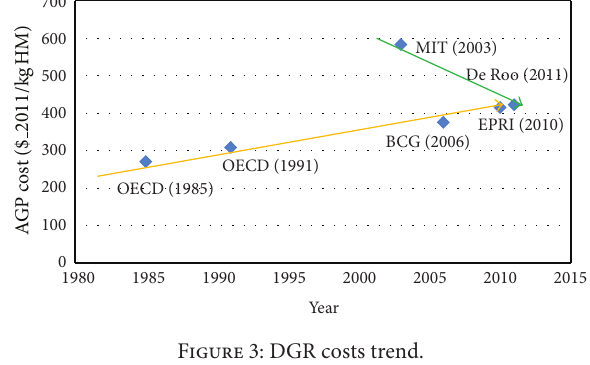
Figure 3: DGR costs trend.